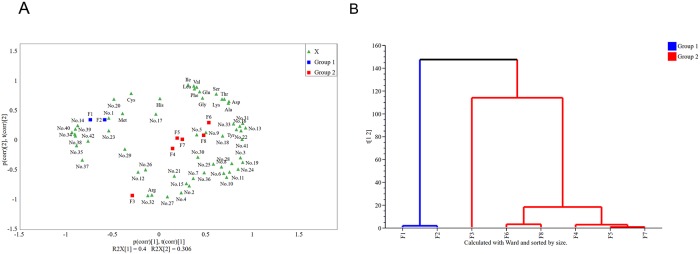
Flavor compound structural analysis during the douchi fermentation process.(a) PCoA of flavor components generated during douchi fermentation. Green box indicates the flavor components, blue triangle indicates group 1, and red triangle denotes group 2. The grouping mode is based on Hellinger distances with 97% similarity. (b) HCA of the flavor components generated during douchi fermentation.